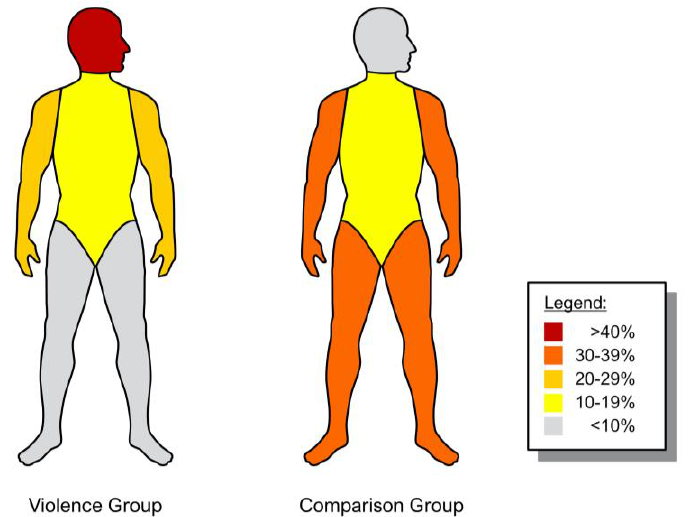
Figure 2. Shown are the frequencies (in percent) of injuries to the respective body regions affected in a direct comparison of the groups (left = violence group; right = comparison group). The trunk region includes the entire spine, thorax, abdomen and pelvis. Copyright is held by the corresponding author.